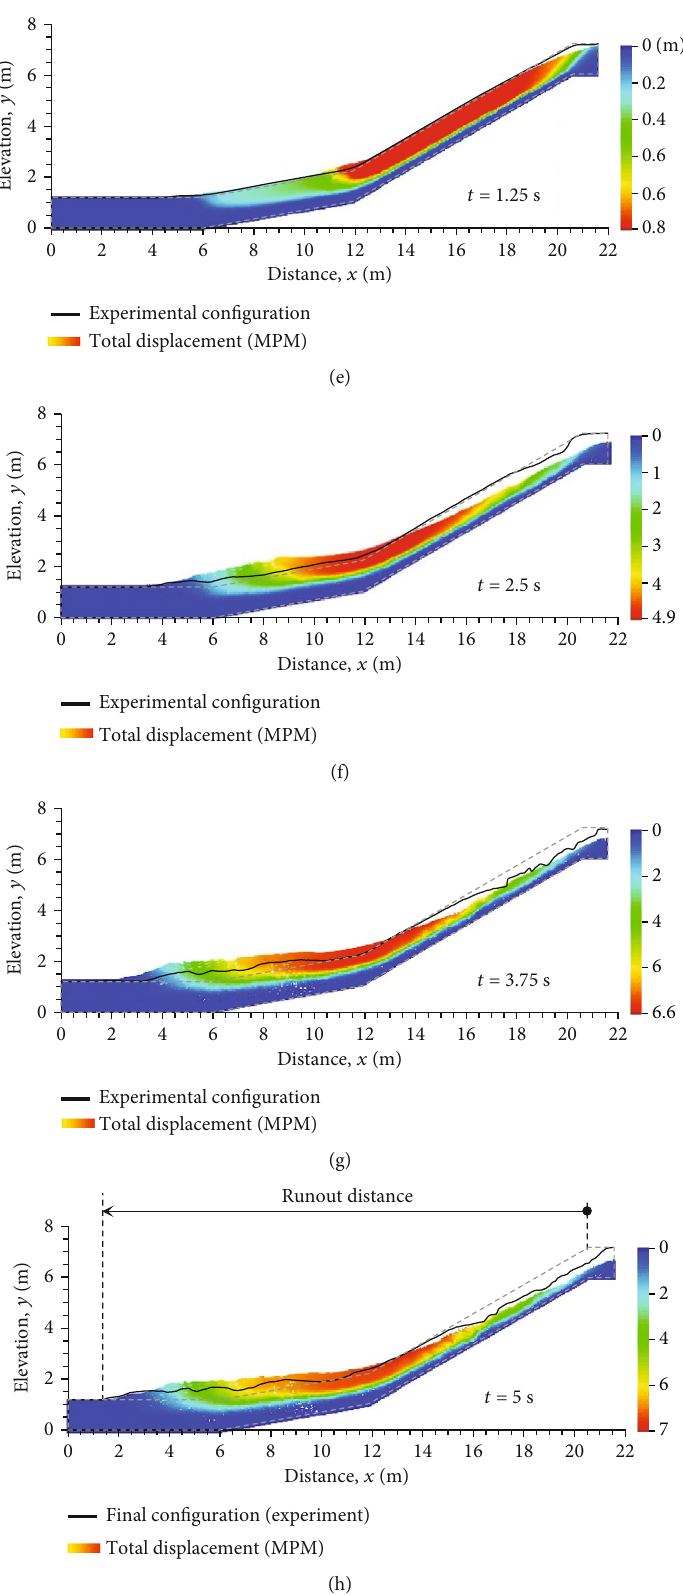
Figure 3: Comparison of the progress of the landslide between predicted and measured results in terms of: (a – d) deviatoric strain and (e – h) displacement